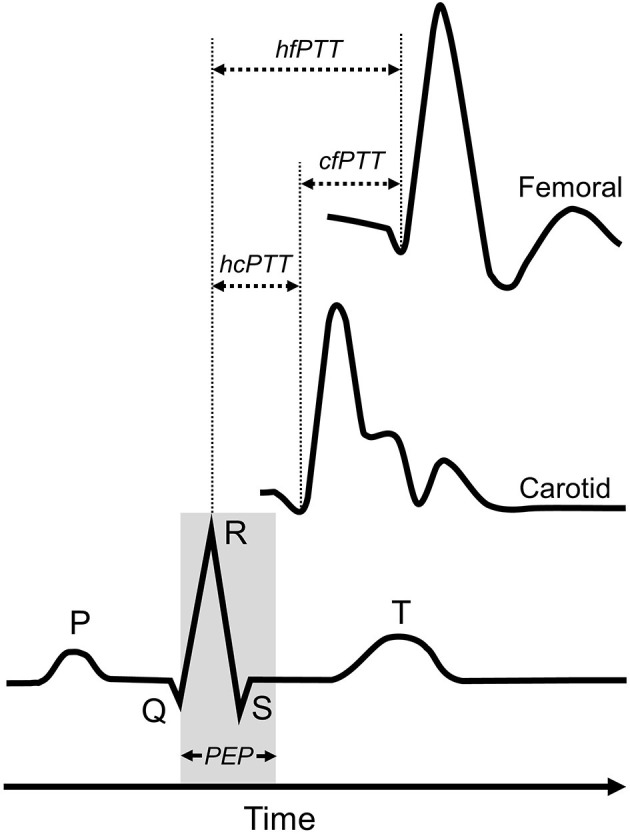
Determination of pulse-transit time (PTT) for heart-femoral pulse-wave velocity and carotid-femoral pulse-weave velocity measures. Carotid-femoral PTT (cfPTT) was calculated as heart-femoral PPT (hfPTT) minus heart-carotid PTT (cfPTT). PEP, pre-ejection period.